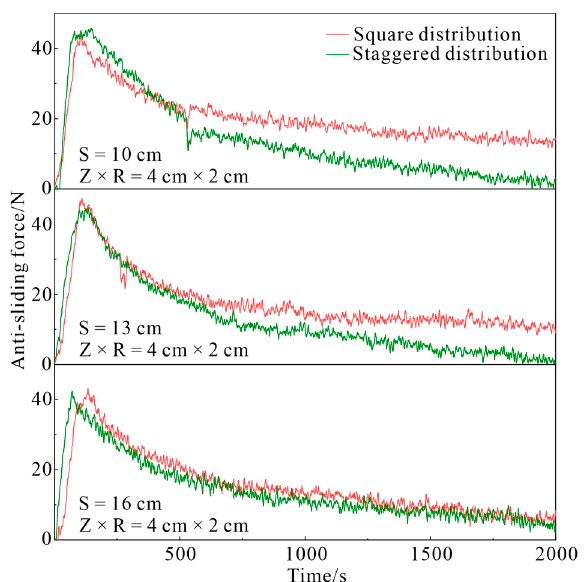
Figure 10. Effect of planting pattern of tap-like root system on anti-sliding force with constant root volume.